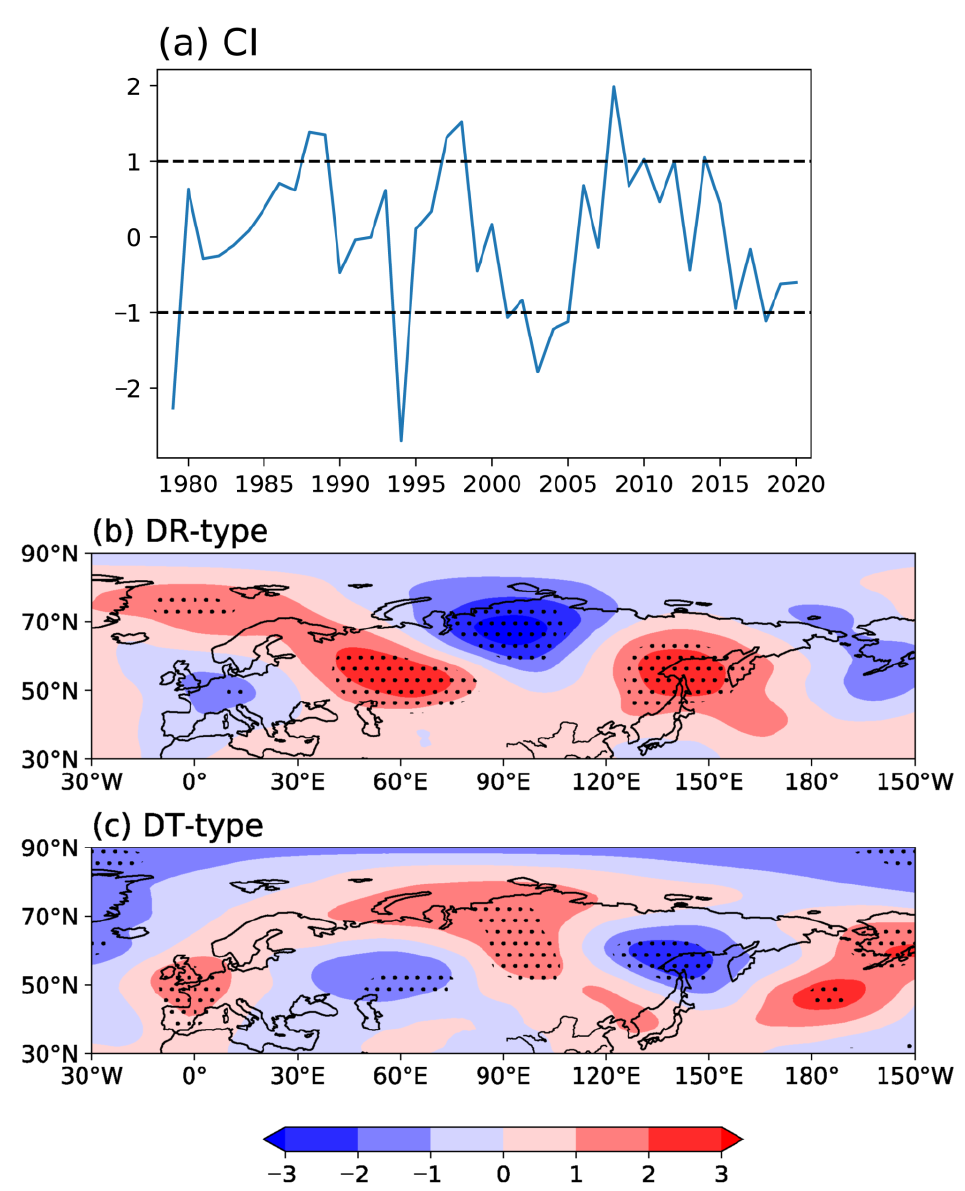
Figure 1. ( a ) The normalized time series of the CI for 1979–2020. The horizontal dashed lines indicated ± 1.0 standard deviation. Composite summer geopotential height anomalies at 500 hPa (shading, units: dagpm) for ( b ) DR-type and ( c ) DT-type. The 500 hPa geopotential height anomalies significant at the 90% confidence level are dotted.